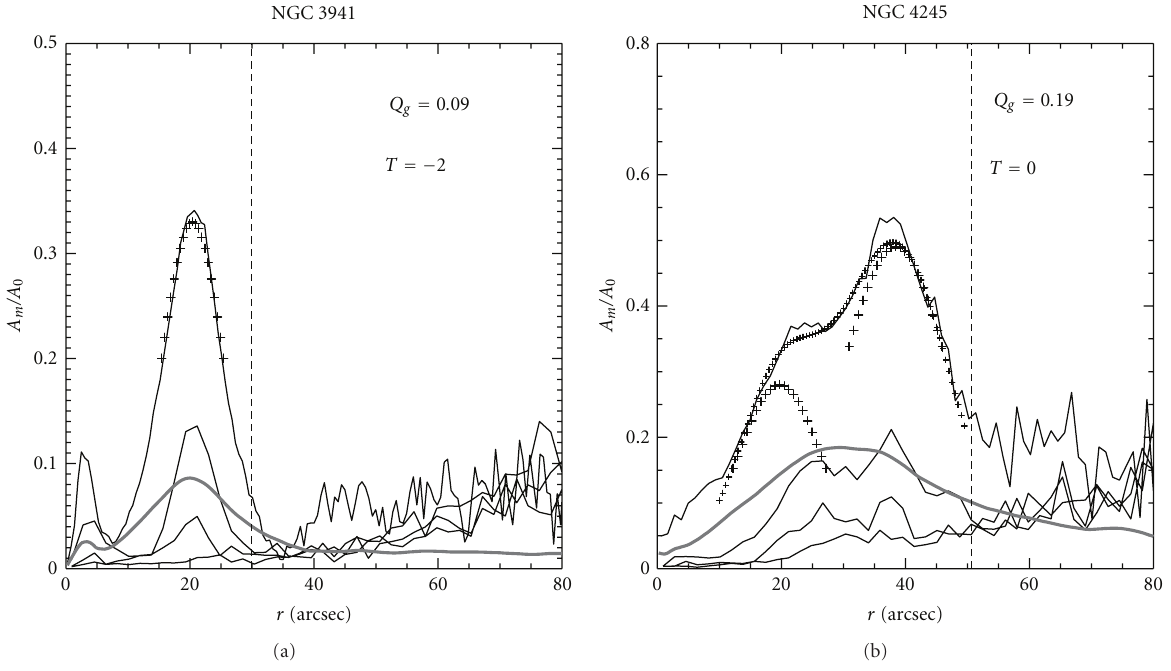
Figure 4: Radial profiles of the Fourier amplitudes of density: (a) shows a simple bar, whereas (b) shows a two-component bar: both lower and higher Fourier modes are significant in these two components. The thin lines show the m = 2,4,6,8 Fourier’s amplitudes, normalized to m = 0. The thick grey line shows the force ratio QT ( r ) = | FT ( r , φ ) | max / (cid:5)| FR ( r , φ ) |(cid:6) ( Q g indicates the maximum of QT ), and the vertical line indicates the length of the bar. The crosses show individual Gaussian fits to the m = 2 Fourier’s amplitude profile. The single-peaked bar represents a thin classical bar. The double-peaked amplitude profile is associated to a bar having a shorter and vertically thicker inner part and a longer and vertically thinner outer part. This figure is a modified version of Figure 8 in Laurikainen et al.